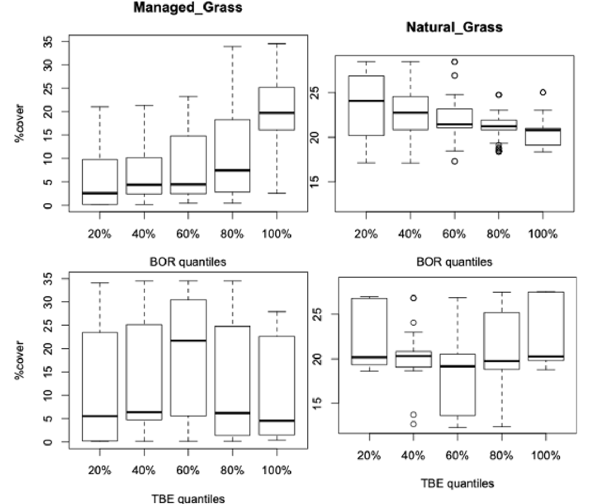
Figure 7. Boxplots for the managed grass and natural grass cover fractions for the WI districts per quantile ranges of disease